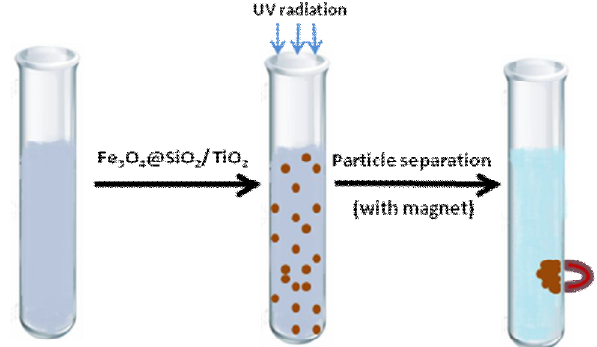
Fig. 3. Steps of the proposed wastewater treatment.